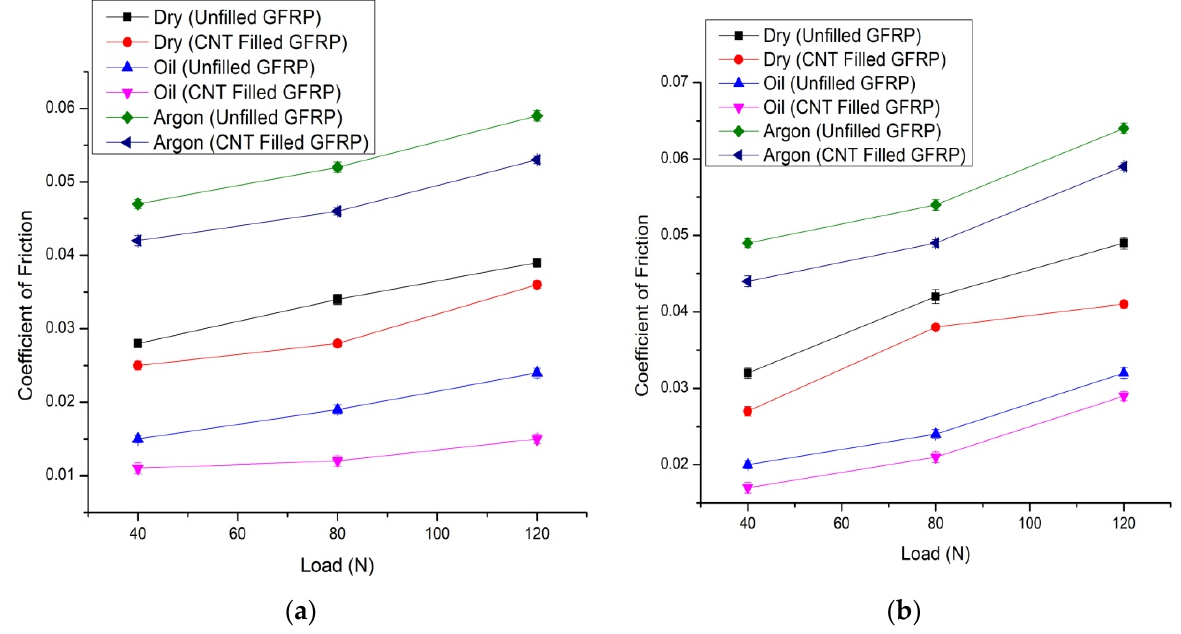
Figure 5. ( a ) Coefficient of friction v/s load for CNT filled GFRP and unfilled GFRP composites, during all the three cases at 2.51 m/s and for 1508 m, and ( b ) Coefficient of friction v/s normal load for CNT filled GFRP and unfilled GFRP composites, during all the three environmental conditions at 3.14 m/s and for 2828 m.